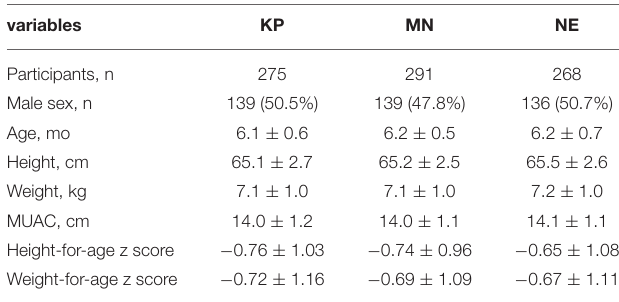
TABLE 1 | Baseline characteristics for children included in the plasma amino acids analysis a